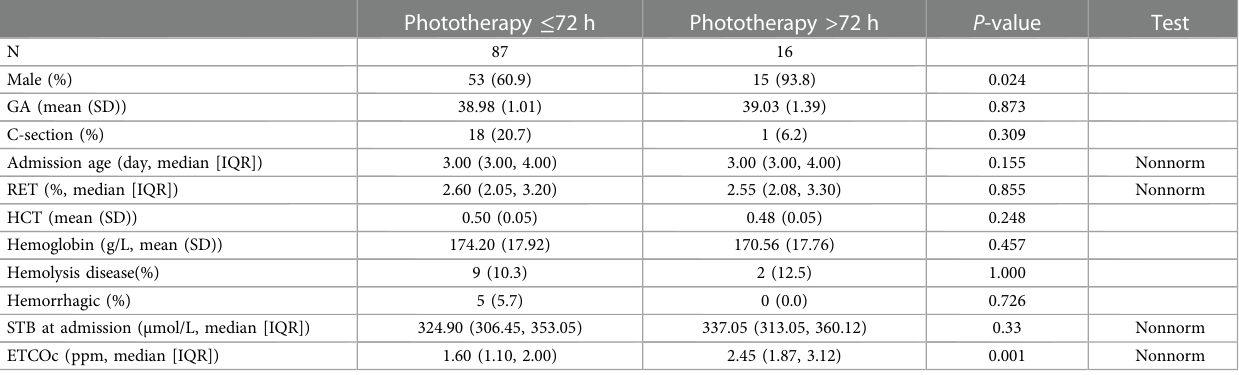
TABLE 1 Comparative analysis of factors categorized by phototherapy duration ≤ 72 h and>72